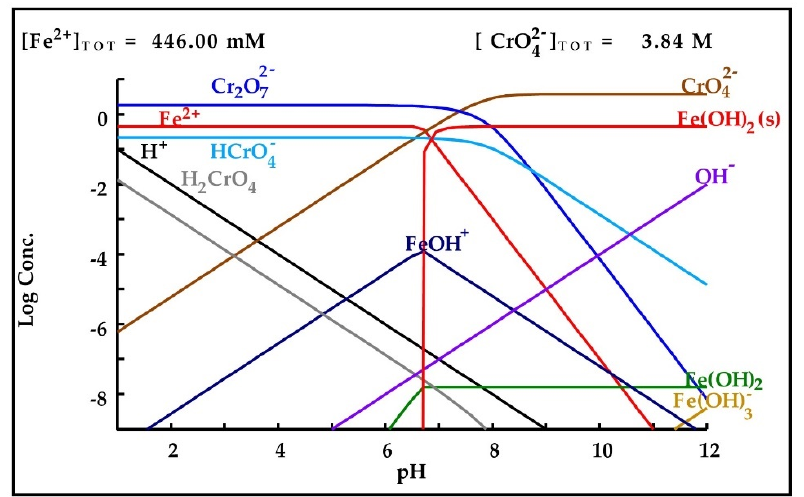
Figure 1. Species distribution diagram calculated by the software Medusa for the system concentra- tions of HCrO 4– and Fe 2+ .